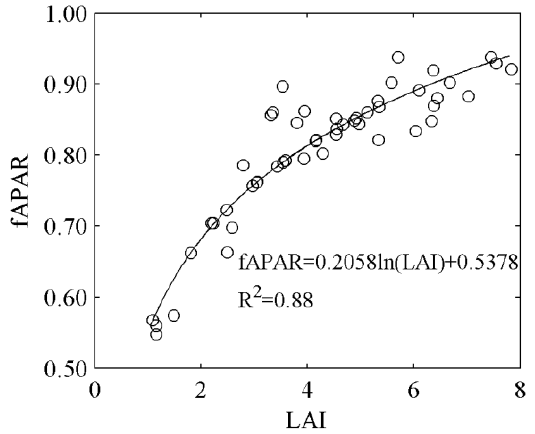
Figure 8. fAPAR as a function of LAI for the forest stands at three test sites ( n = 42). Both, fAPAR and LAI were measured in the